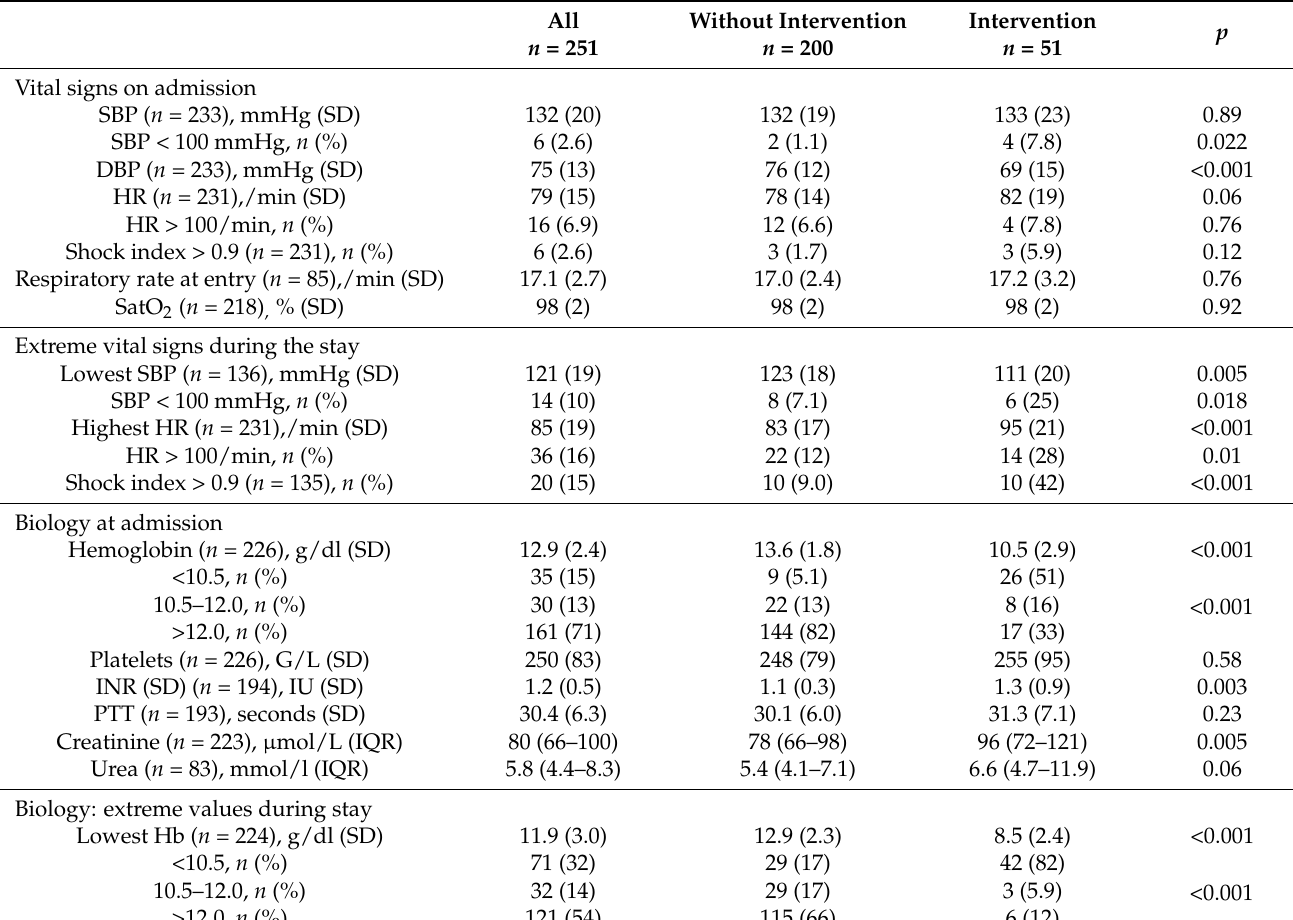
Table 2. Vital signs and biological workup at